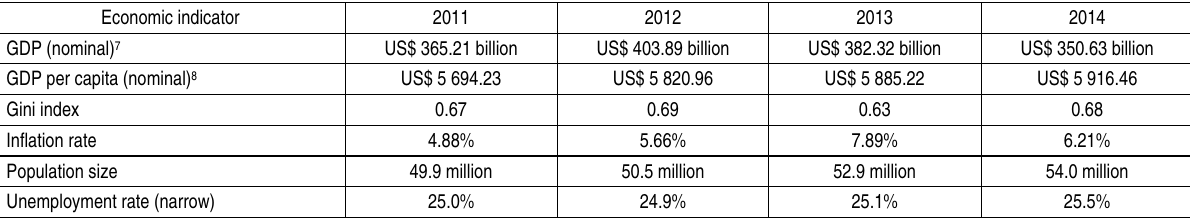
Table 2. Economic indicators of the South African economy